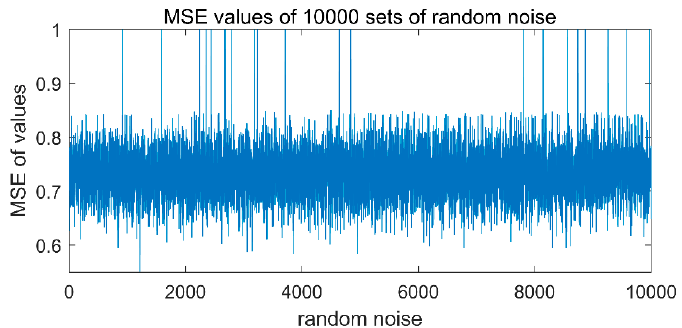
Figure 7. Multi-scale sample entropy (MSE) values of 10,000 sets of random noise.